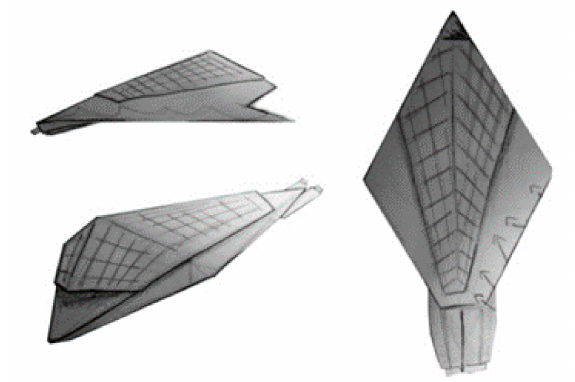
Figure 7. Stone Style